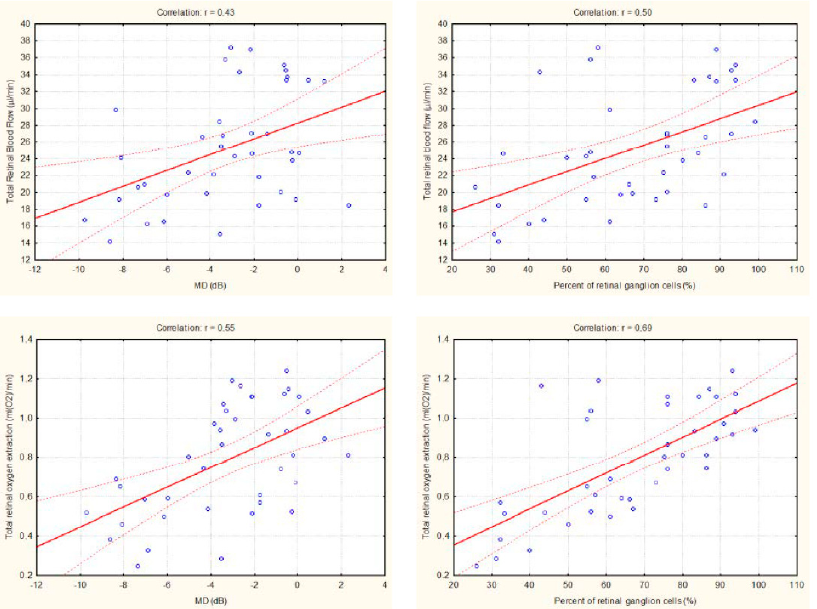
Figure 2. Linear correlation between retinal hemodynamic parameters and measures of structural damage in POAG patients. damage in POAG